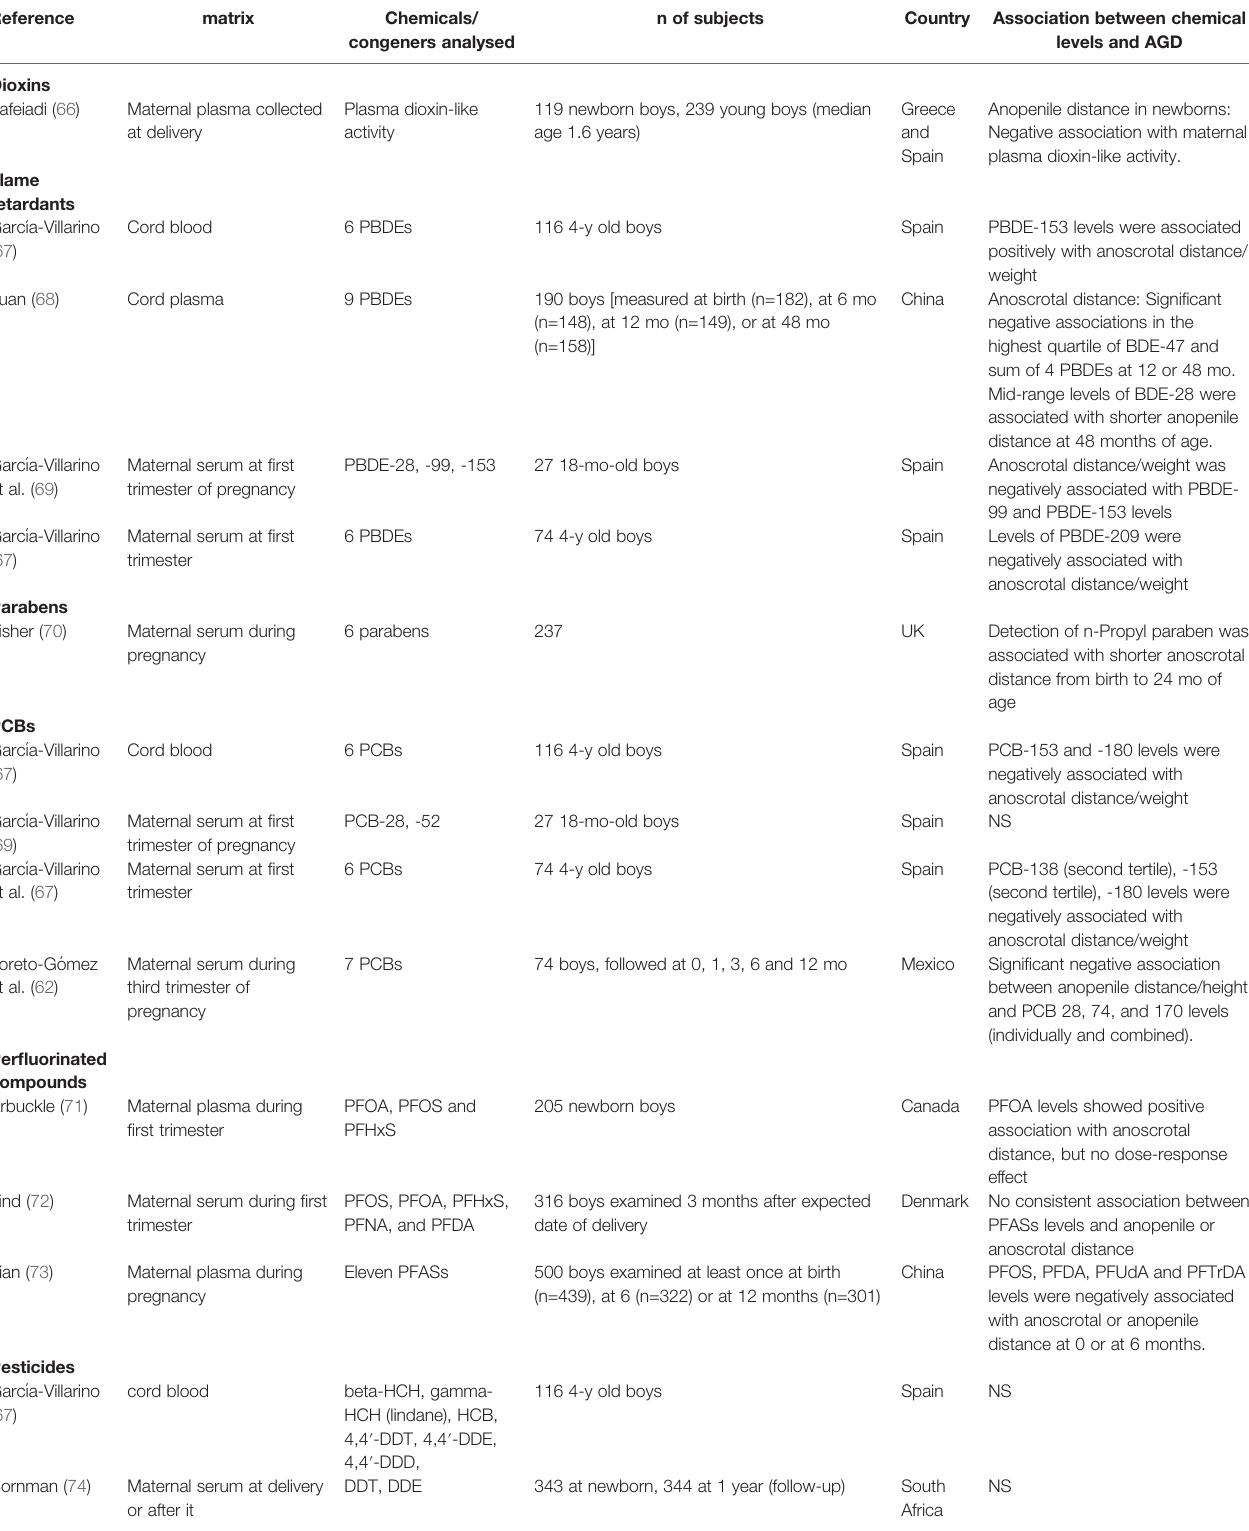
TABLE 1 | Studies on the association between exposure to different classes of environmental EDCs (based on matrix measurements) and anogenital distance in young